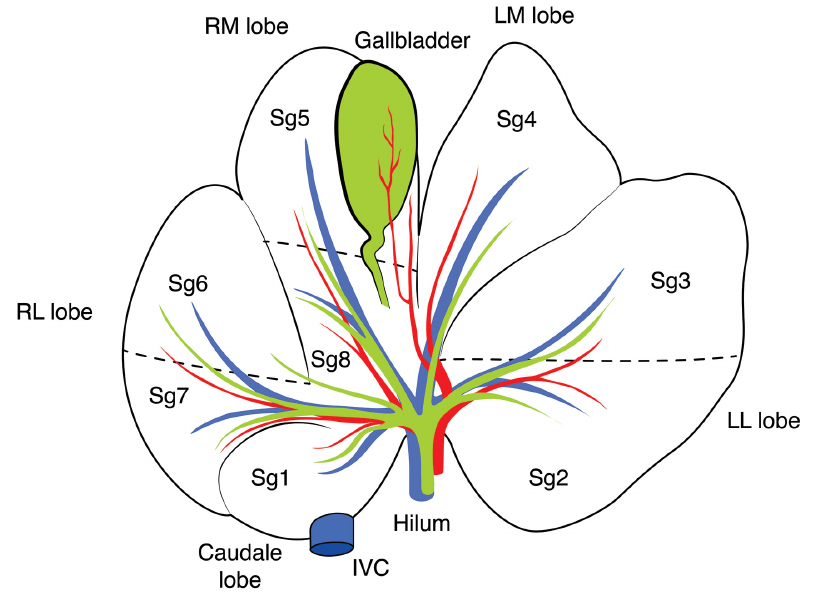
Figure 2. Anatomy of the porcine liver. Bile duct and gallbladder (green); artery (red); portal vein (blue); IVC = inferior vena cava. Dashed lines represent the limits between liver segments (Sg).